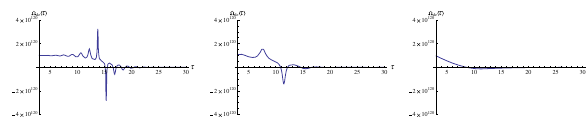
= 10 120 . The 3 H 2 0